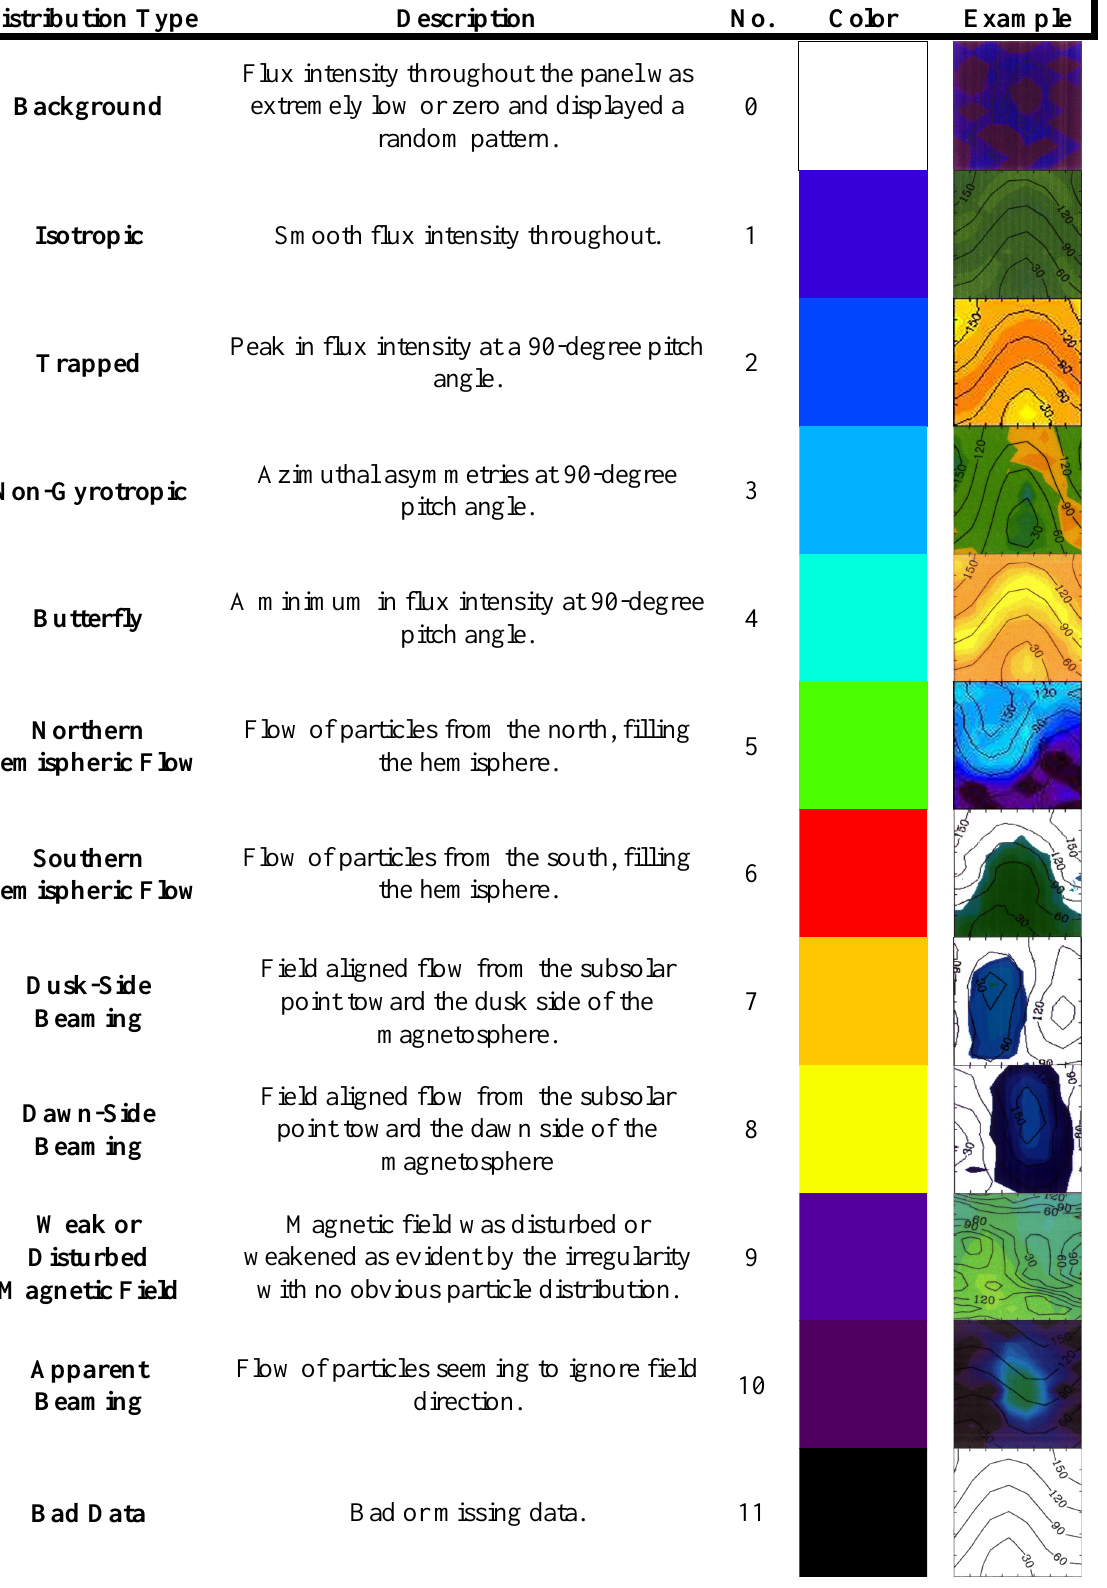
Fig. 2. Examples and short descriptions of the eleven types or categories of PADs with an indication of the numerical and colour-code associated with the respective